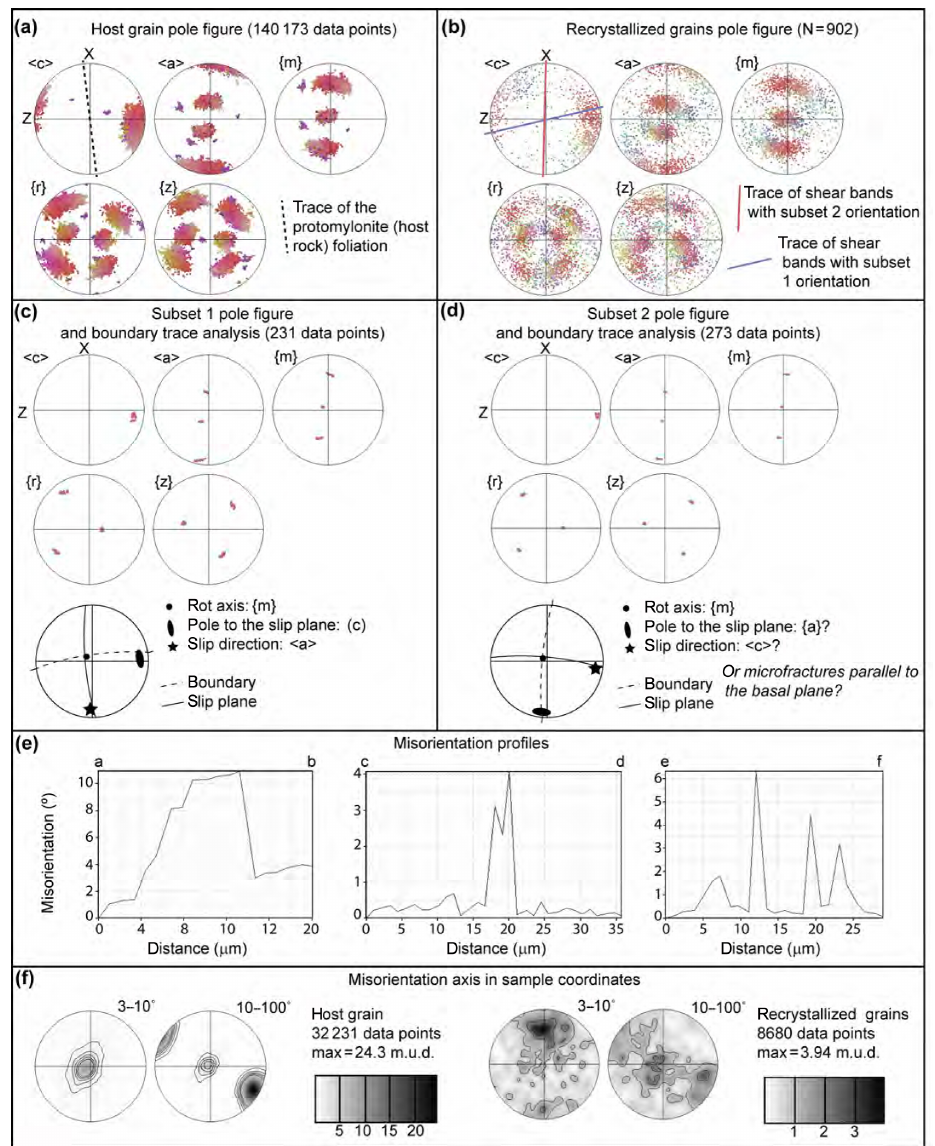
Figure 9. EBSD analysis of quartz in the host protomylonite. (a) Pole figure of the host grain, colour-coded per the quartz inverse pole figure with respect to the protomylonitic foliation shown in Fig. 8b. (b) Pole figure of recrystallized quartz in the intracrystalline bands. The blue and red line indicates the average orientation of the trace of the intracrystalline bands with a subset 1 and 2 orientation, respectively. (c) Boundary trace analysis of the localized extinction band of subset 1. (d) Boundary trace analysis of the localized extinction band of subset 2. (e) Point-to-point misorientation profiles. See Fig. 8b for location of the traces of the profiles. (f) Misorientation axis of the host grain and of the recrystallized grains in sample